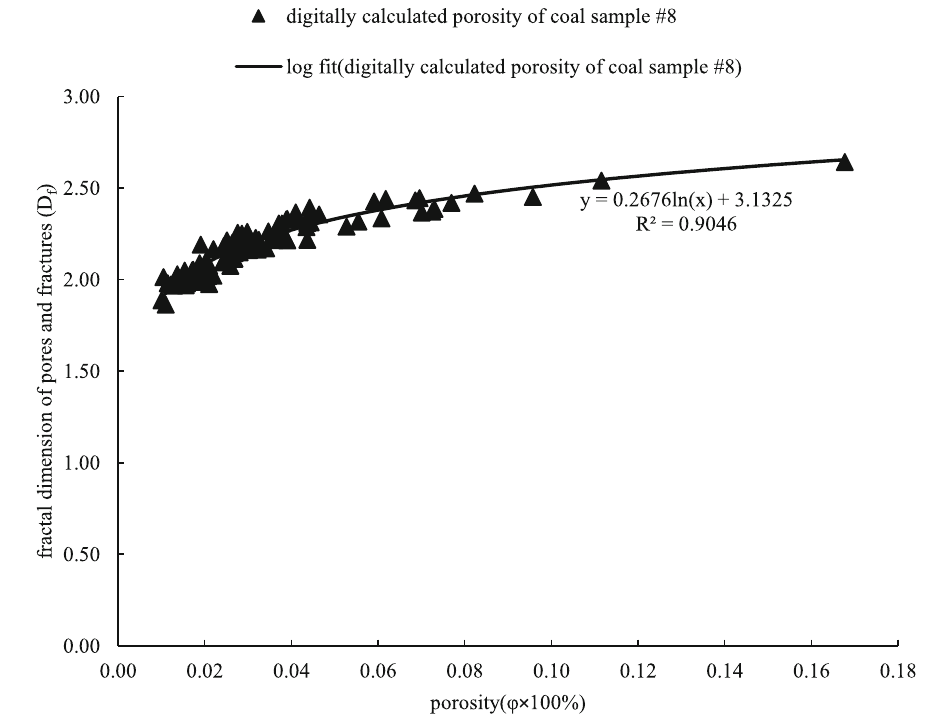
Fig. 7 Fractal dimension vs. porosity cross-plot for the No. 8 coal sample Table 2 Logarithmic functions for fractal dimension versus porosity curves Coal Natural logarithm function Correlation coefficient Coal Natural logarithm function Correlation coefficient R R 2 sample No. sample No.